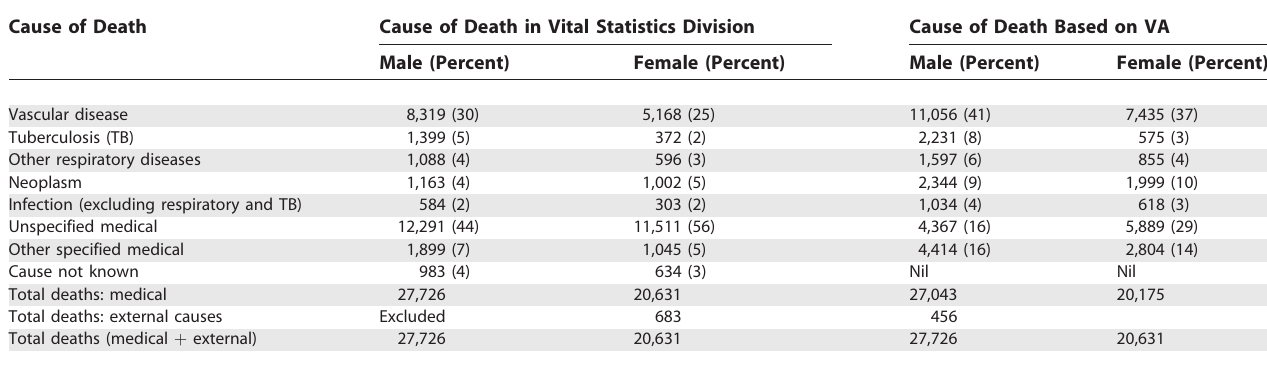
Table 2. Cause of Death Based on Vital Statistics and VA of 48,000 Adult ( . 25 y of Age) Deaths in Chennai, India: 1995–1997 a